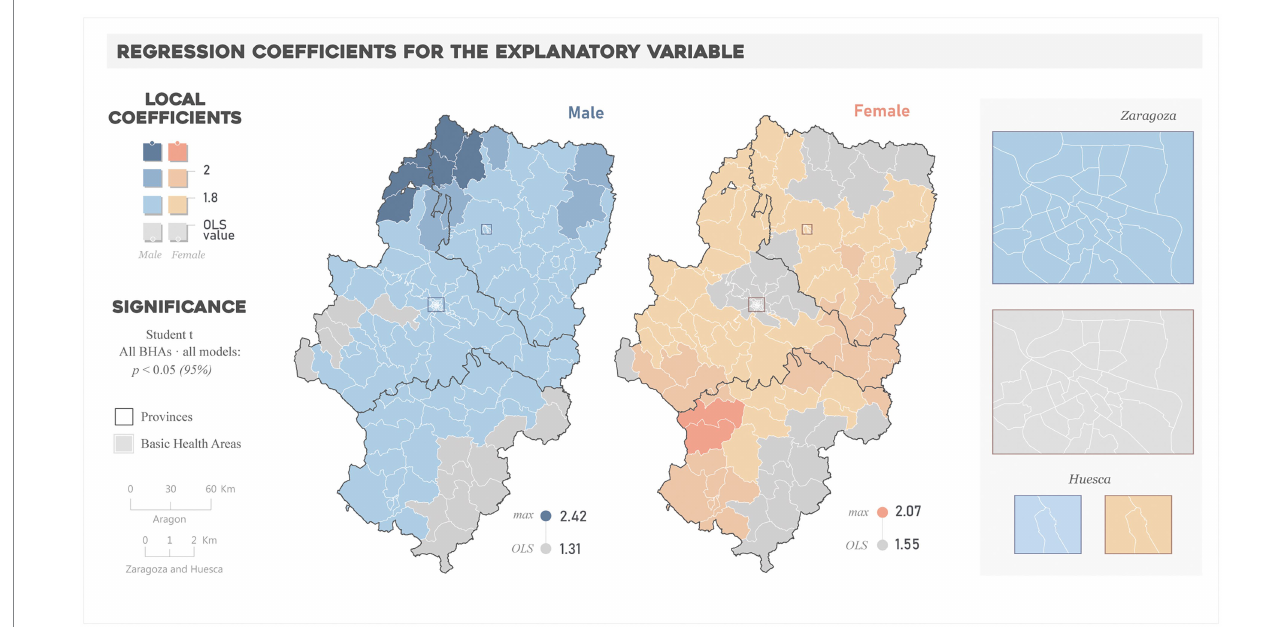
FIGURE 3 Spatial distribution of the regression coefficients for the explanatory variable in “All years” models.